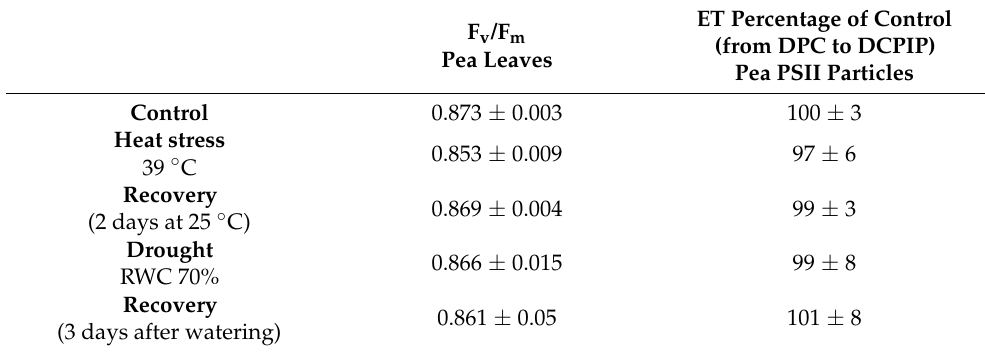
Figure 3. The response of the pea photosystem II (PSII) core population distribution to heat and drought stress analysed by sucrose gradient ultracentrifugation. The PSII particles were isolated from control plants and then subjected to 39 °C for 8 h (columns 3–4). PSII particles were isolated from pea plants grown at 25 ± 2 °C to 8 cm height and subjected as intact seedlings to 39 ± 2 °C for 8 h (columns 5–6). PSII particles isolated from drought-grown pea plants (columns 7–8). The experiment was triplicated. Table 2. Photosystem II activity in peas under stress (heat and drought) measured as the fluorescence F v /F m ratio in leaves and as electron transfer in isolated PSII particles. RWC, relative water content.